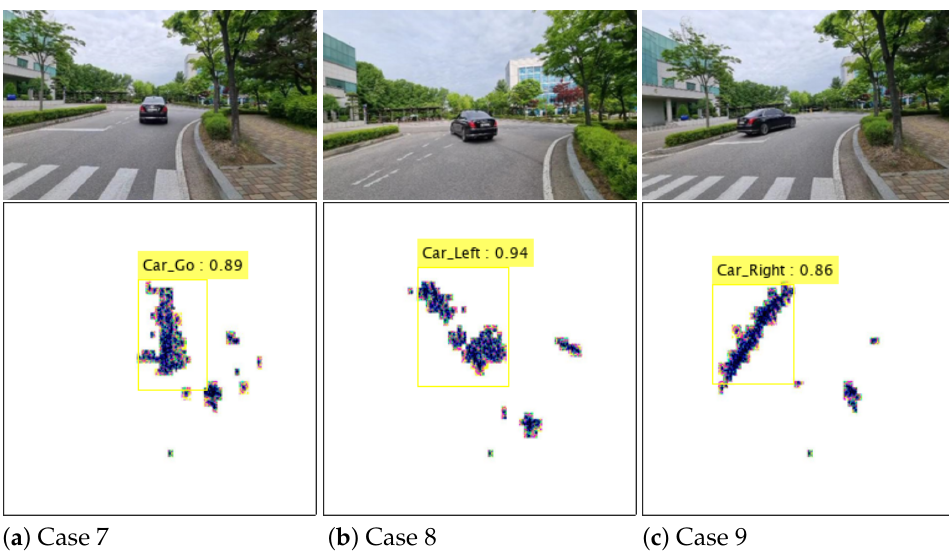
Figure 10. Instantaneous target identification results in new environments: Cases 7 to